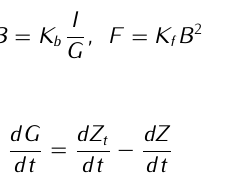
Figure 2. Maglev single-stage suspension non-linearities (Straight lines for theoretical and dotted lines for a practical electro- magnet including leakage and saturation)